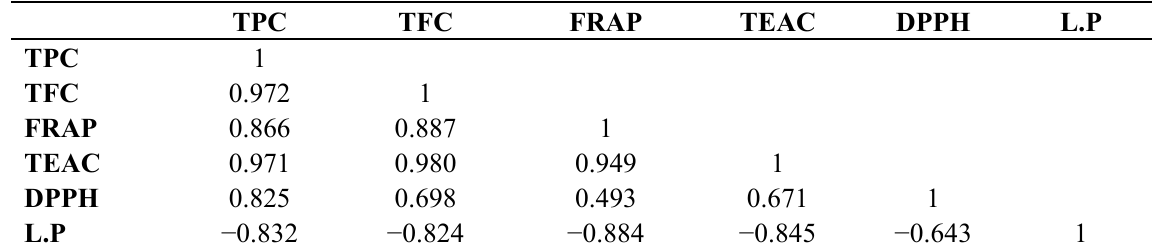
Table 2. Correlation coefficient between TPC, TFC, Lipid peroxidation, FRAP, TEAC and DPPH